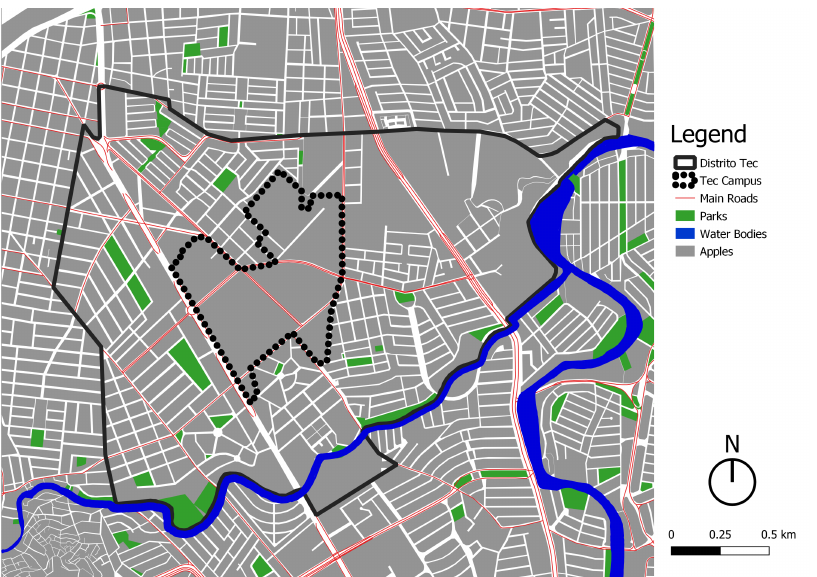
Figure 5. Delimitation of the Distrito Tec area within Monterrey, Mexico. Tec campus, parks, main roads, rivers, and urban blocks are also shown.